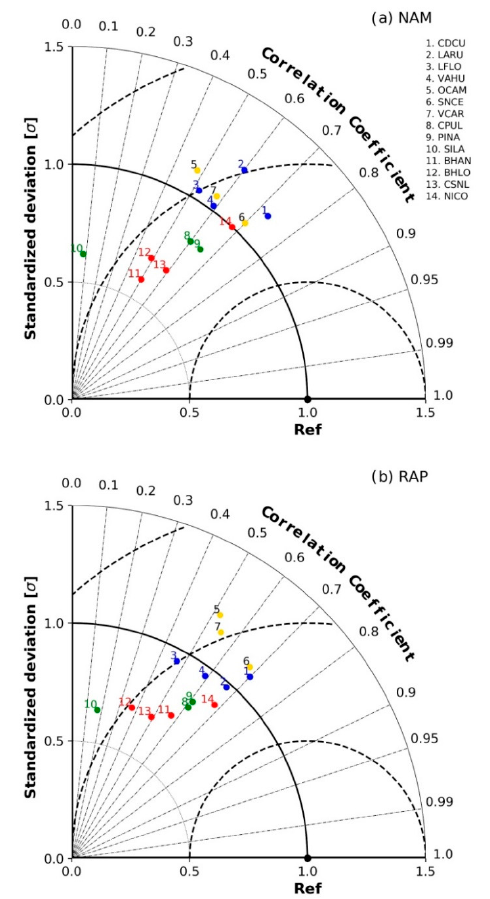
Figure 8. Taylor diagram for ( a ) NAM and ( b ) RAP of forecast 10 m wind speed and observations at 14 weather stations grouped in regions: Plateau (blue dots), NEMEX (yellow dots), GoC (green dots) and BCP (red dots). The radial coordinate is the magnitude of the standard deviation, which is normalized by the standard deviation from observation and denoted by black dot lines. The concentric black semi-circles denote centered root-mean-square (CRMS) difference values. The angular coordinate shows the correlation coefficient (denoted by grey dot lines).